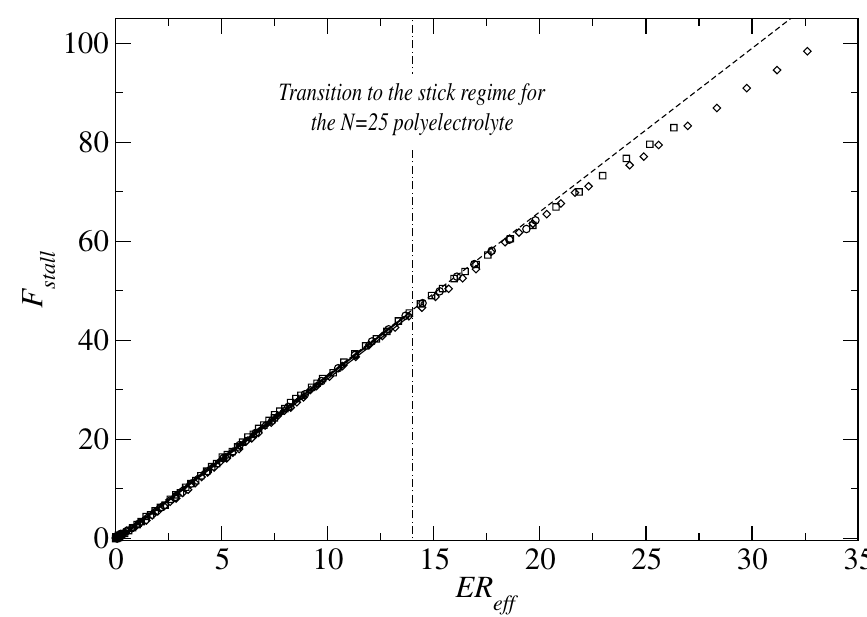
Fig. 7. Comparison of the relationship between the stall force F and the electrical field E (( ) N = 15, ( ! ) N = 20, (( ) N = 15, stall eff ◦ ◦ ( ♦ ) N = 25) with the intuitive prediction that F = F = E stall Q E (the various lines). tot = 2 . 1). 2